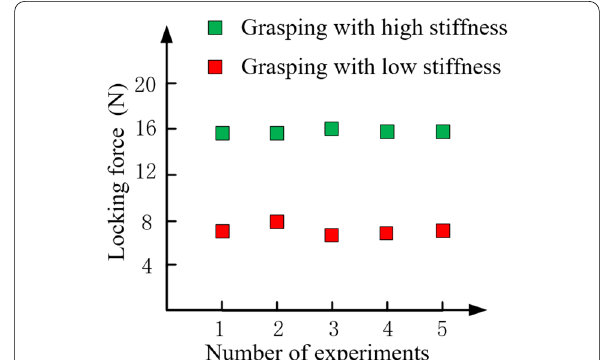
Figure 14 Locking